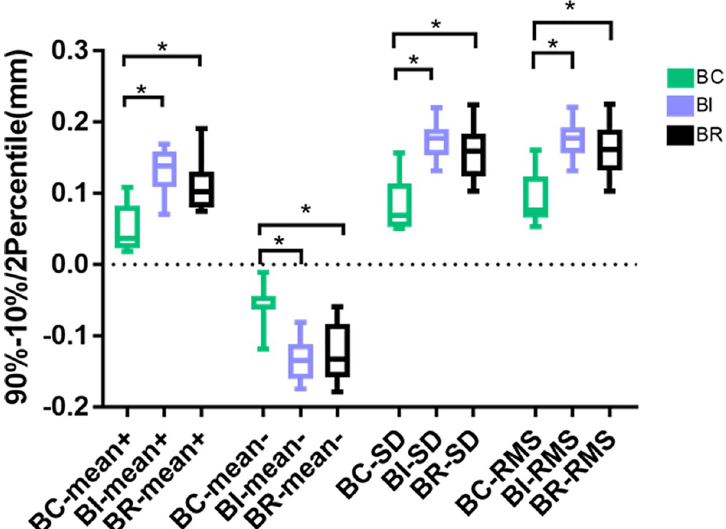
Fig 8. The average positive and negative deviations, standard deviations and RMS values between the auto- generated crowns and the modified crowns. � p <